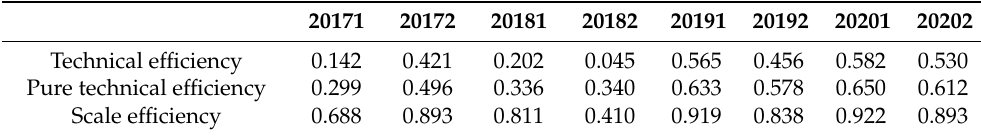
Table 4. Average of initial green financing efficiency in the first